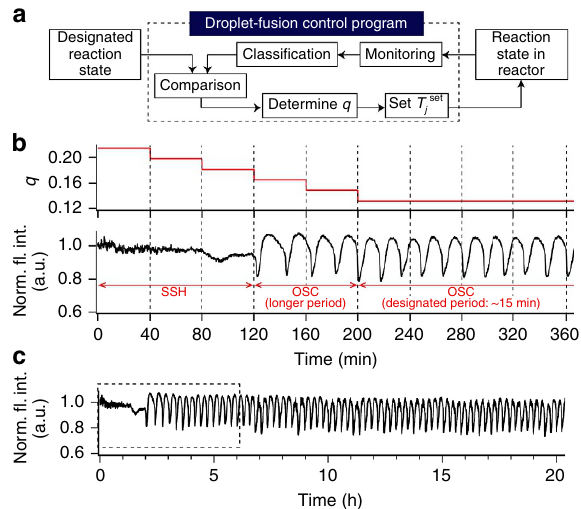
Figure 5 | Feedback control of BSF pH oscillation using the droplet open- reactor system. ( a ) Scheme of feedback control. The droplet-fusion control programme fluorescently monitors and classifies the current reaction state in the reactor (SSH, SSL and oscillation of pH). The droplet-fusion control programme compares the reaction state with a designated one; when they are different, the droplet-fusion control programme automatically changes q by changing T j set to obtain a reaction state closer to the designated one. ( b ) Time course of q (upper) and normalized fluorescence intensity (Norm. fl. int.; lower) during feedback control (designated period: 15min). Initial condition q ¼ 0.215 ( T j ¼ 4.62s). The change in q per step was 0.0165. ( c ) Long-term observation of oscillation after applying the feedback control in b (box indicated by dashed lines). The compositions of the solutions in the transporter and reactor are given in the Methods